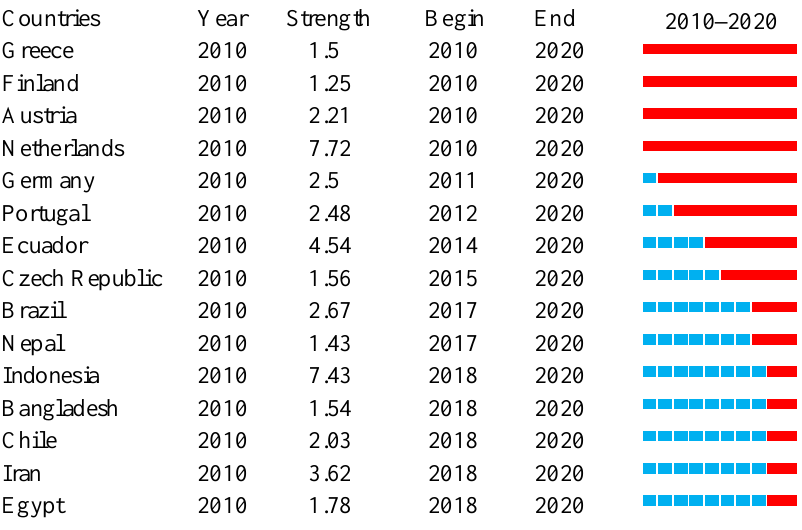
Figure 4. Top 15 countries with the strongest citation bursts.